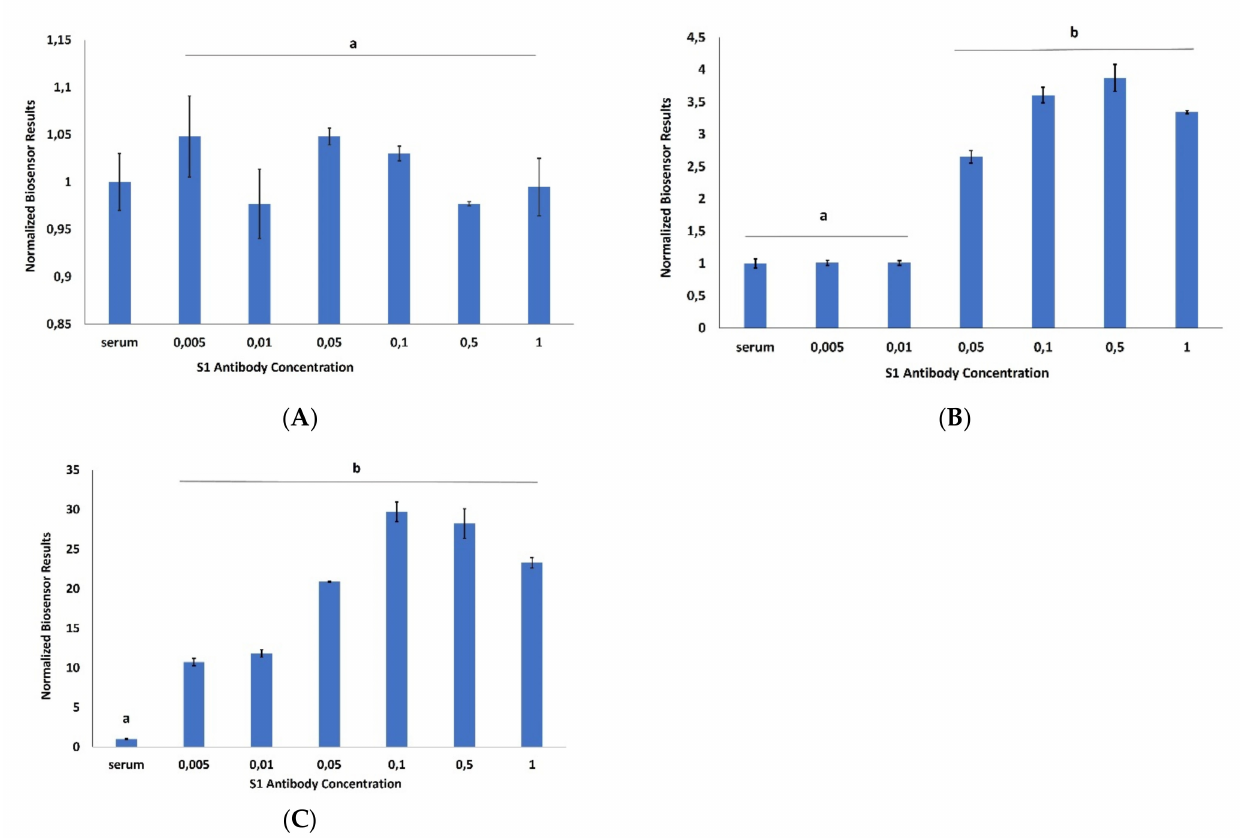
Figure 2. Optimization of biosensor’s responses against 6 different spiked concentrations of the SARS-CoV-2 S1 antibody (0.005, 0.01, 0.05, 0.1, 0.5, 1 µ g/mL) in human blood serum. Responses of membrane-engineered SK-N-SH cells with ( A ) Plain PBS, ( B ) 0.5 µ g/mL S1 protein, and ( C ) 5 µ g/mL S1 protein. Results are presented as normalized biosensor responses (n = 24). a: non-statistically significant different results. b: statistically significant different results ( p <